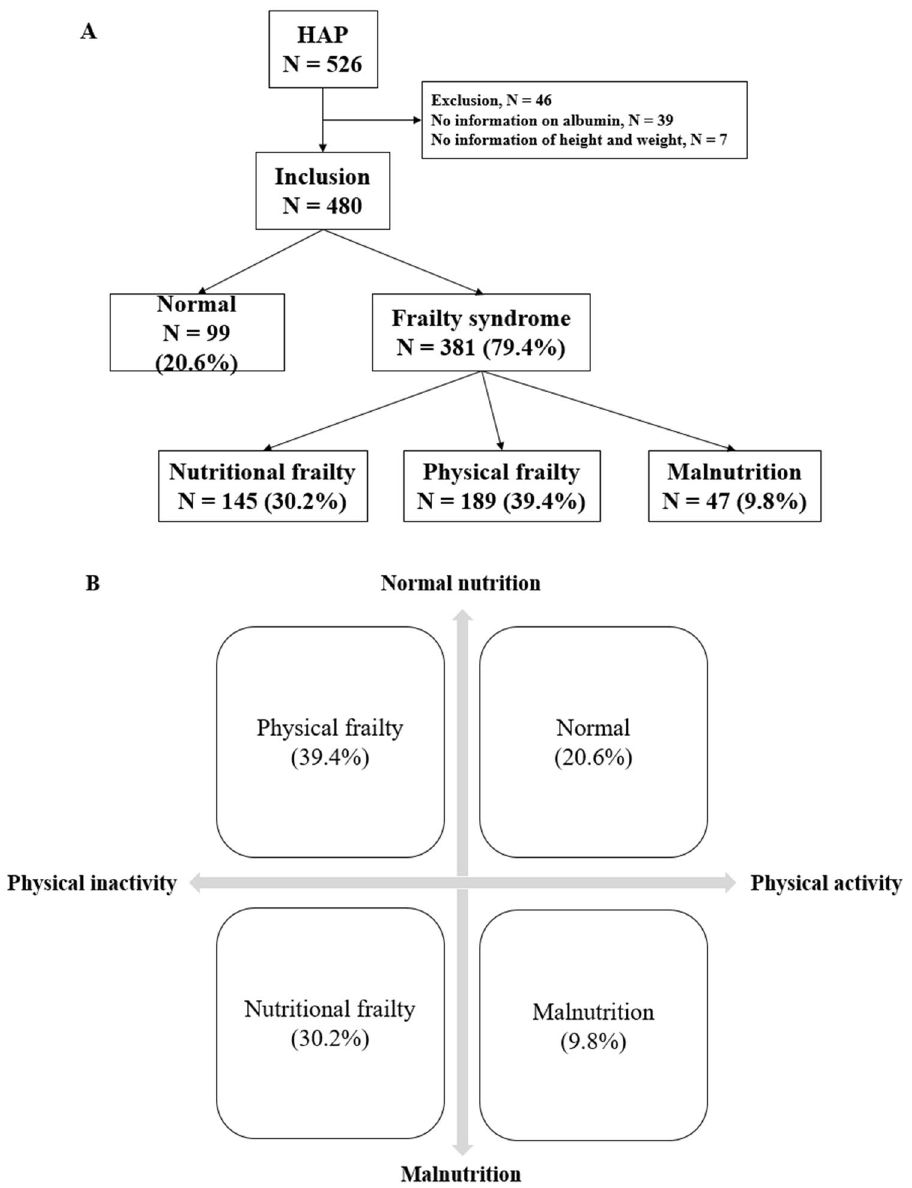
Figure 1. ( A ) Flowchart of the patient enrollment process. During the study period, 526 patients were screened for HAP/VAP. Among them, 480 were included and divided into four groups according to physical inactivity and malnutrition. HAP hospital-acquired pneumonia. ( B ) Phenotypes of frailty. Patients were divided into four groups according to physical inactivity and malnutrition: nutritional frailty, physical frailty, malnutrition, and